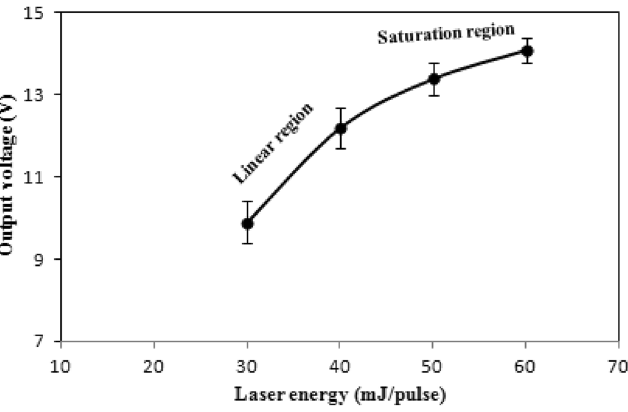
Figure 7. Variation of output voltage with pulse laser energy at zero bias for an Sb detector deposited at θ = 70°.